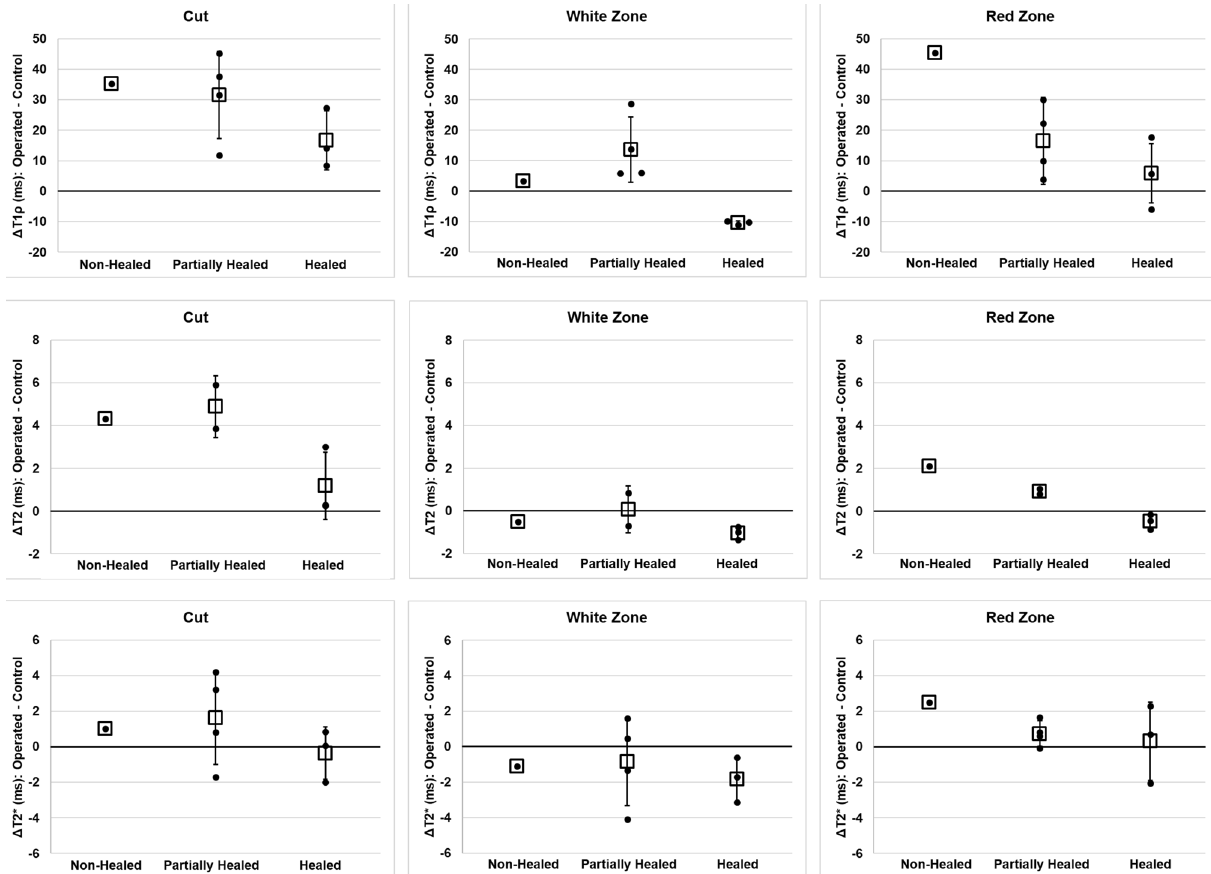
Figure 6. Relaxation time differences (Δ) between the operated and control menisci. The relaxation time differences were calculated in three ROIs: near the tear site (first column); the white zone side of the tear site (second column); and the red zone side of the tear site (third column). Three relaxation times were evaluated: adiabatic T1ρ (first row); T2 (second row); and T2* (third row). Individual data points are shown as black dots, their mean is plotted as a square, and the error bars show the standard deviation of the mean. Since there was only one non-healed tear, there are no error bars for this